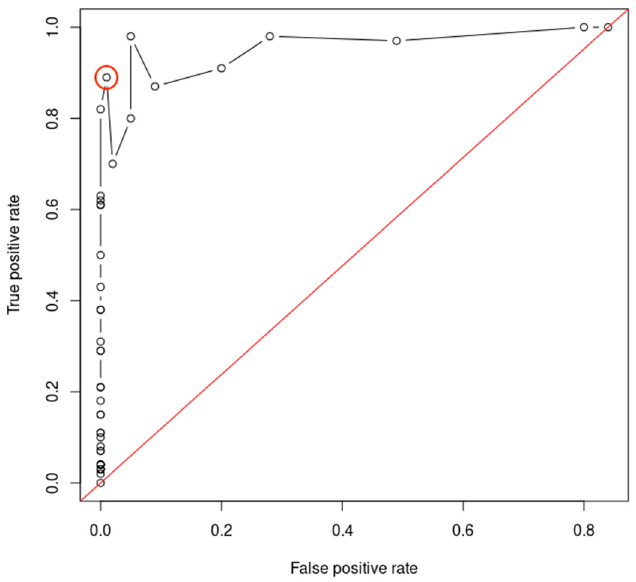
Figure 3. ROC (receiver operating characteristic) curve. True positive rate vs. false positive rate on 100 files containing calls and 100 files with no calls randomly chosen in the total dataset. The diagonal red line shows the performance of a random classifier: Points above the diagonal represent good classification results. The red circle highlights the threshold values that guaranteed the best performance of the detector.